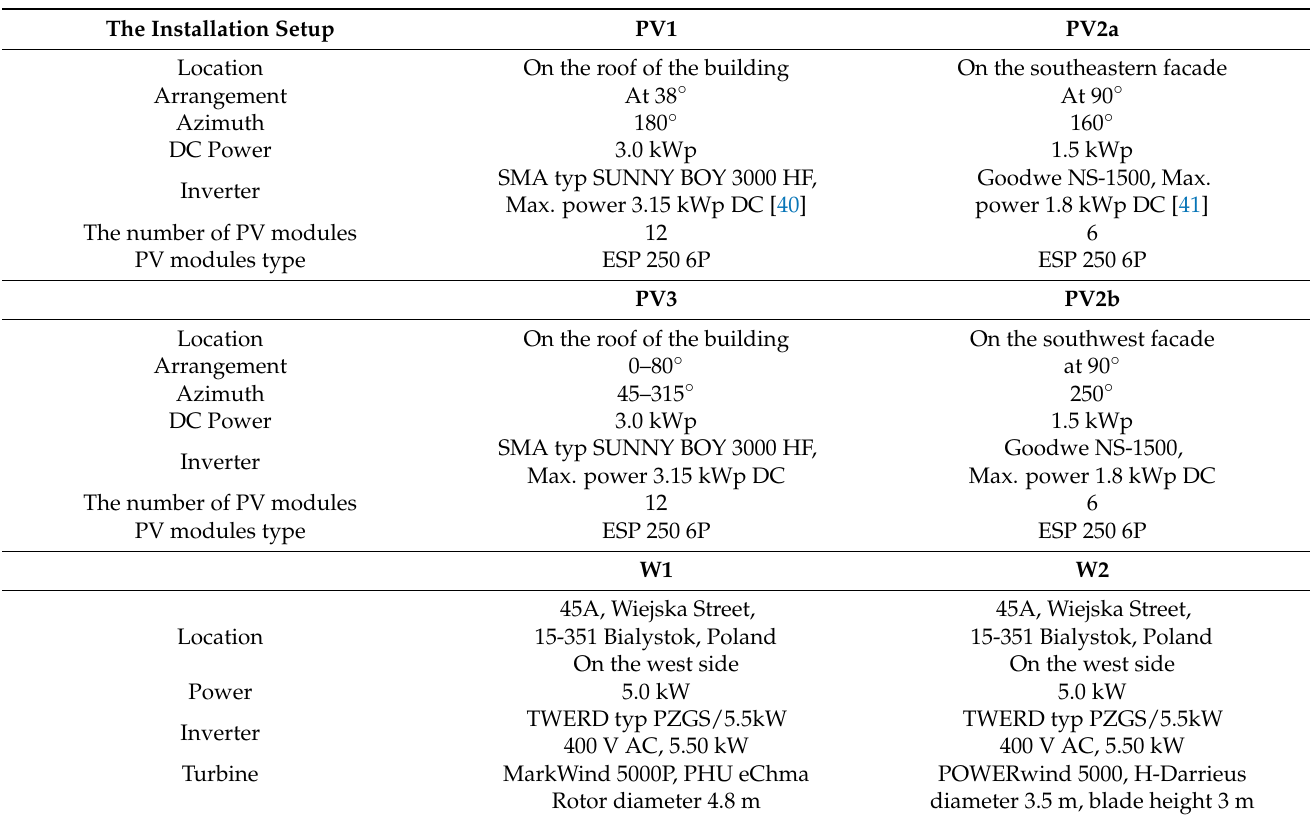
Table 1. Elements of the power plant under study.